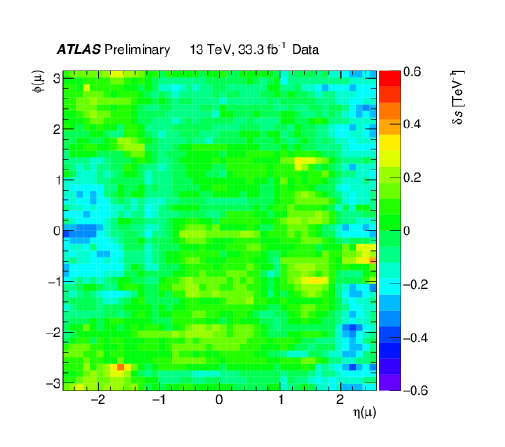
Figure 3. Transverse momentum ( p T ) scale as a function of pseudorapidity ( η ) obtained from µ + µ − candidates. The dataset, reconstructed Z → consisting of 33.3 fb − 1 of proton-proton collision data collected in 2016 by the ATLAS detector at a center-of-mass energy of √ s = 13 TeV is shown for µ + µ − candidates with a positive reconstructed Z → leading muon (blue square markers) and negative leading muon (red circle markers) before (unfilled markers) and after (filled markers) correcting for possible misalignments of the Inner detector. Data are also compared to prompt Z simulation (continuous line). Systematic uncertainties (filled area) are derived from 1 σ variations of the smearing and ± scale parameters used to derive the correction. An uncertainty accounting for the missmodeling of the fitting function due to the missing background component is also taken into account. Figure from [5]. Figure 4. Residual local sagitta bias δ s for combined muons as a function of η and ϕ , as evaluated from µ + µ − decays with transverse momenta from 5 Z → GeV to 300 GeV, after application of the correction to data. Figure from